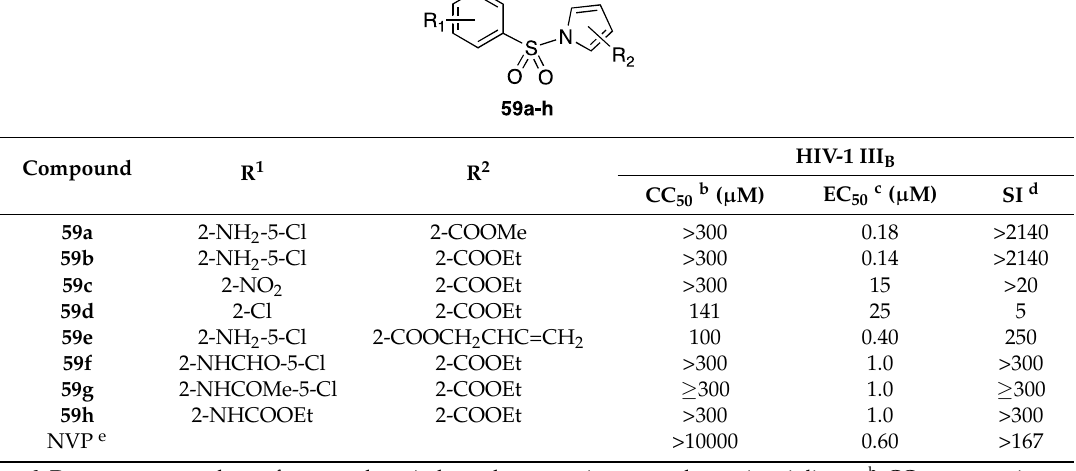
Table 6. Anti-HIV-1 activity of PAS 59a – h against the